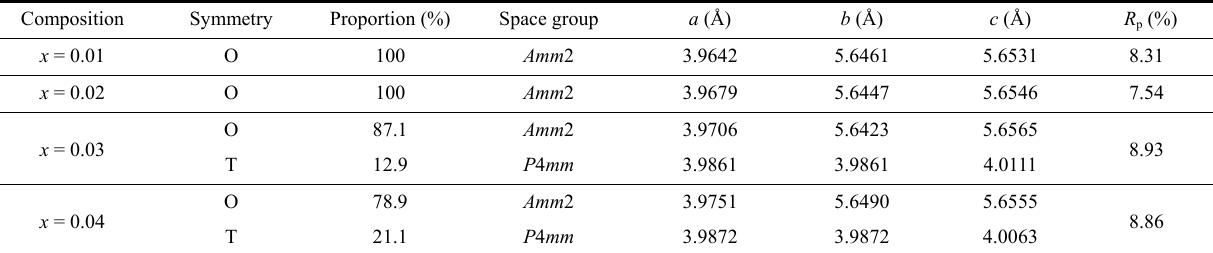
Table 1 Results of Rietveld refinement of XRD patterns for LKNNS  EuNZ  x BZ ceramics